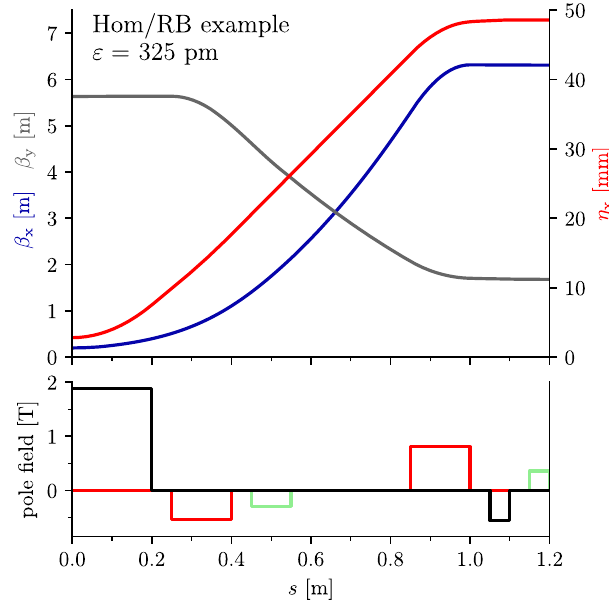
FIG. 14. Example RB cell with homogeneous main bend, utilizing a reverse bend for suppression of dispersion at main bend (see Fig. 4 for legend.)